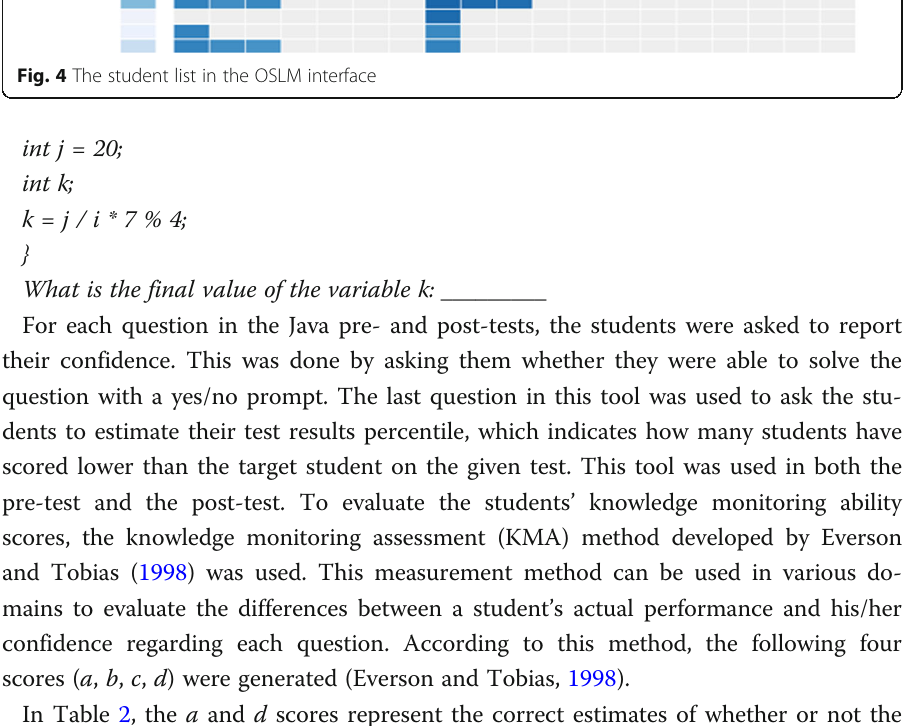
Student ’ s confidence Solved